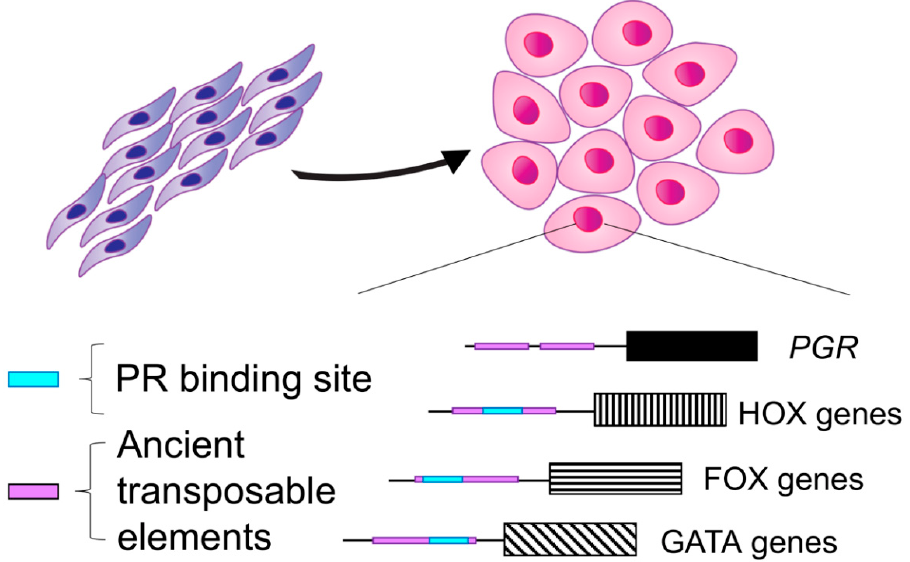
Figure 1. Evolution of progesterone receptor (PR) action in endometrial stromal cells gave rise to decidualization. Decidualization is a feature that evolved in Eutherian mammals and was partly driven by the integration of ancient transposable elements within the gene-regulatory sequences of key masters of decidualization, such as the gene encoding the progesterone receptor ( PGR ) and the HOX, FOX, and GATA gene families. Analysis of PR binding sites in decidual stromal cells